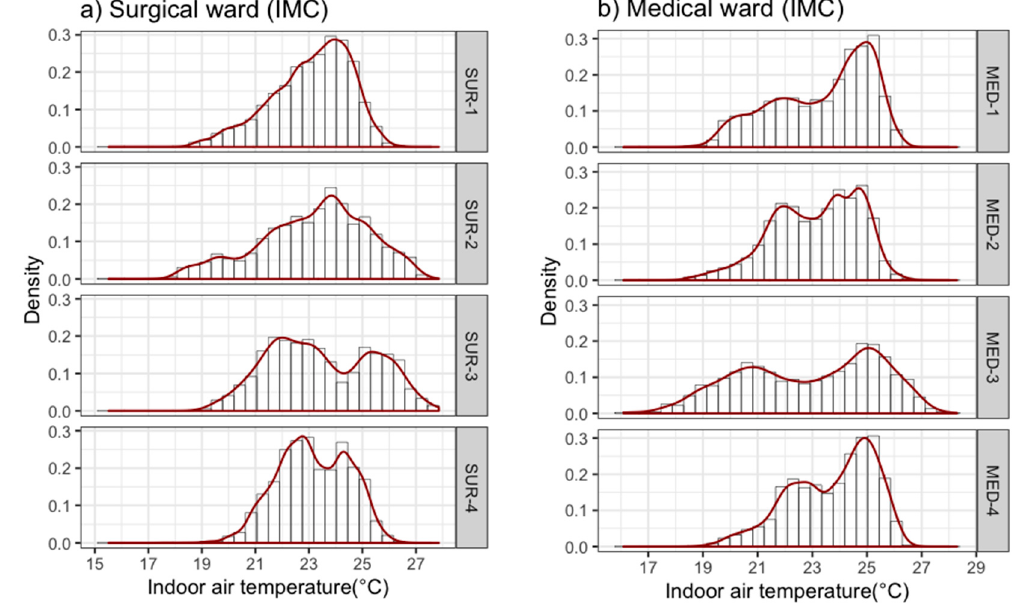
Figure 7. Distributions shapes of T a at IMC. (red curve refers to kernel smoothing), ( a ) Surgical ward (IMC), ( b ) Medical ward (IMC). Buildings 2020 , 10 , x FOR PEER REVIEW 10 of 17